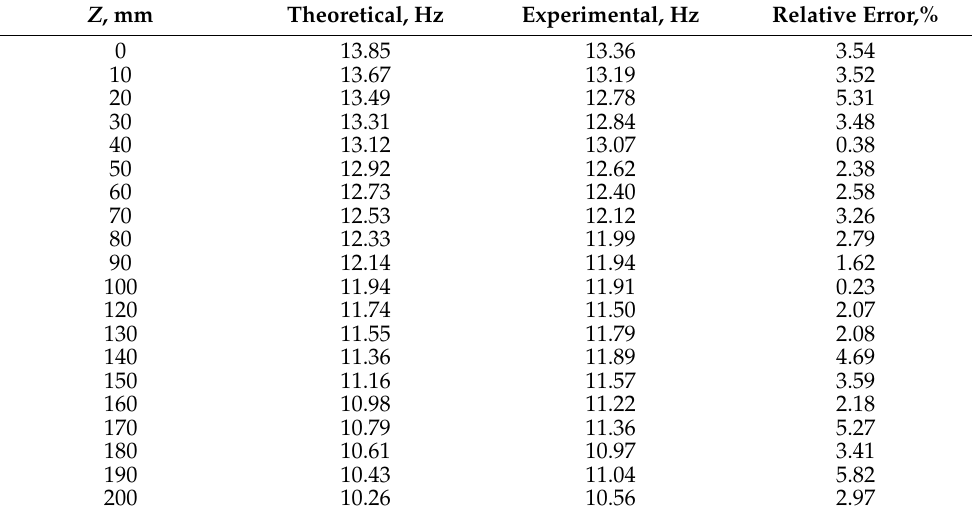
Table 1. The first mode of the Anycubic i3 Mega 3D printer. Z , mm Theoretical, Hz Experimental, Hz Relative Error,% 0